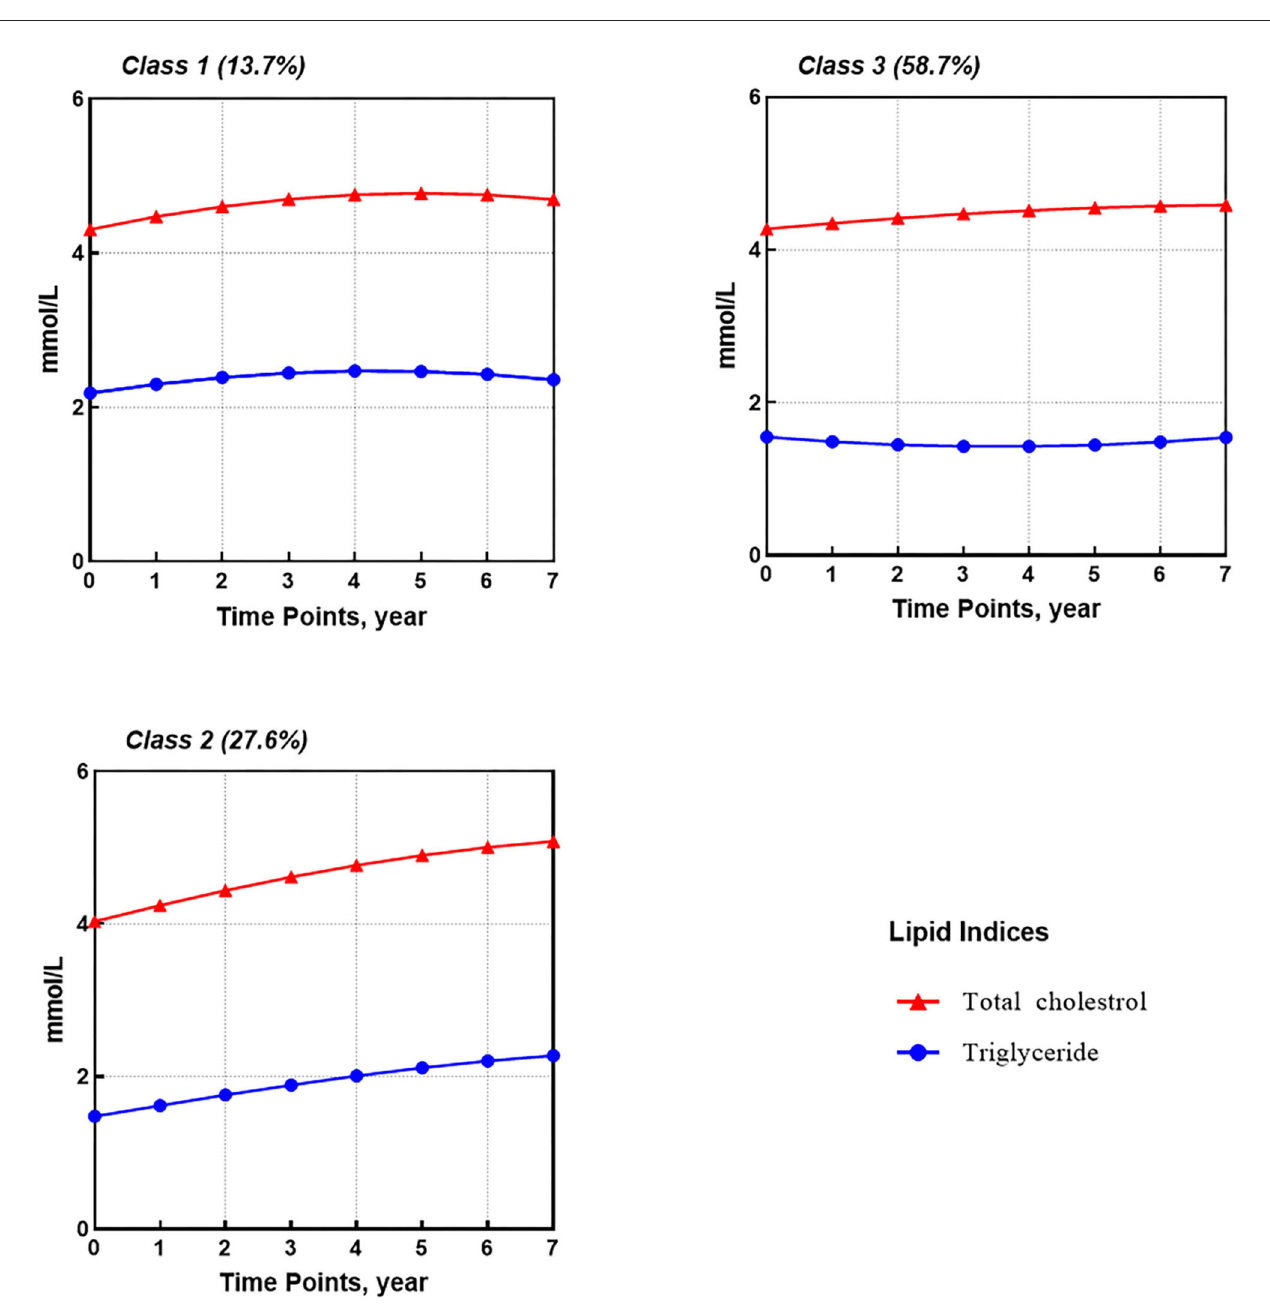
FIGURE2 Dual-trajectories of TG and TC after HAART initiation identified by GMM ( n = 1,572).